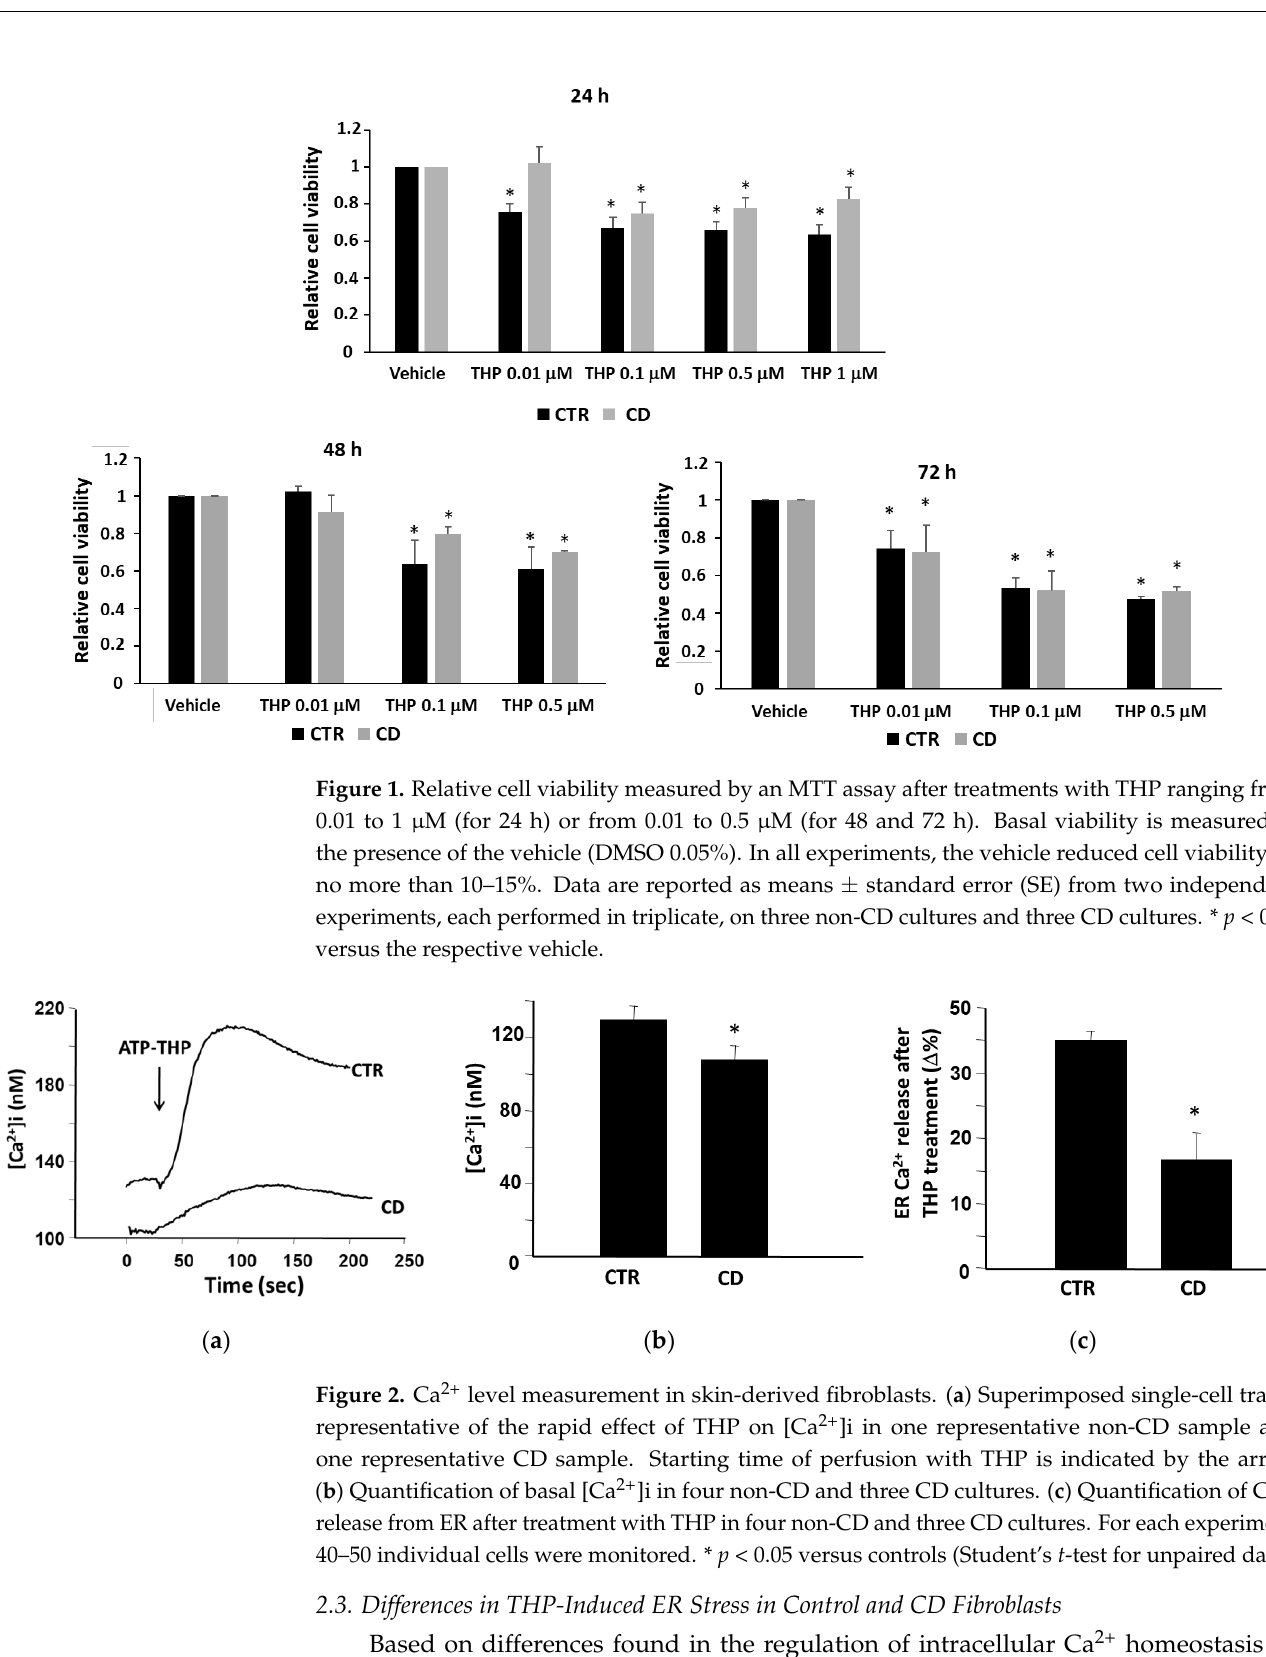
Figure 2. Ca 2+ level measurement in skin-derived fibroblasts. ( a ) Superimposed single-cell traces representative of the rapid effect of THP on [Ca 2+ ]i in one representative non-CD sample and one representative CD sample. Starting time of perfusion with THP is indicated by the arrow. ( b ) Quan- tification of basal [Ca 2+ ]i in four non-CD and three CD cultures. ( c ) Quantification of Ca 2+ release